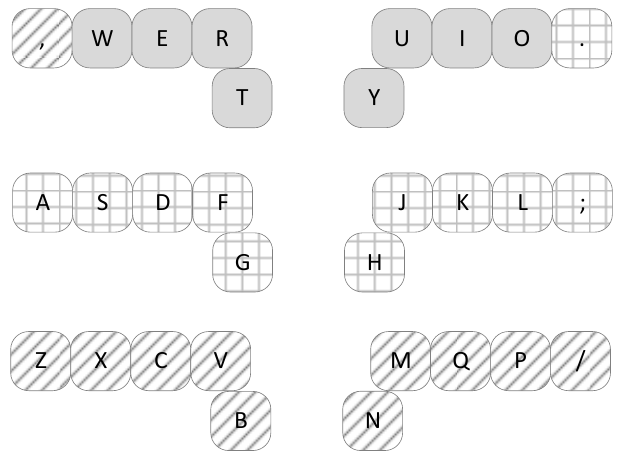
Figure 6. Q-VX-ORK+ arrangement.